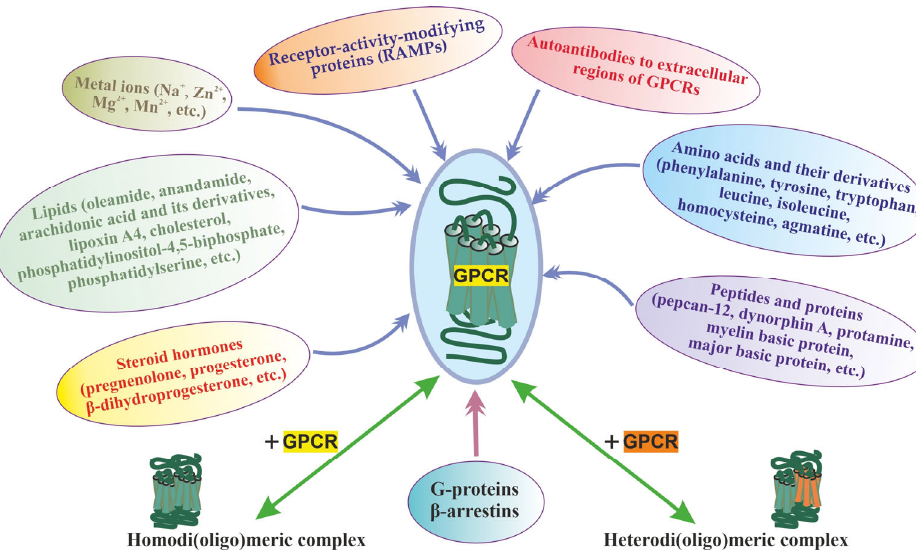
Figure 1. The main group of allosteric regulators of GPCRs, including the homo ‐ and heterodimerization, along with the main classes of allosteric regulators (ions, lipids, amino acids, peptides, proteins, steroid hormones, autoantibodies to extracellular regions of GPCRs), the heterotrimeric G proteins, β‐ arrestins, and RAMPs are shown, which form complexes with GPCRs during signal transduction acting allosterically on their functional activity. The allosteric effect of homo ‐ and heterodi(oligo)merization of the receptors has also been shown, as demonstrated for class C GPCRs and some representatives of the class.